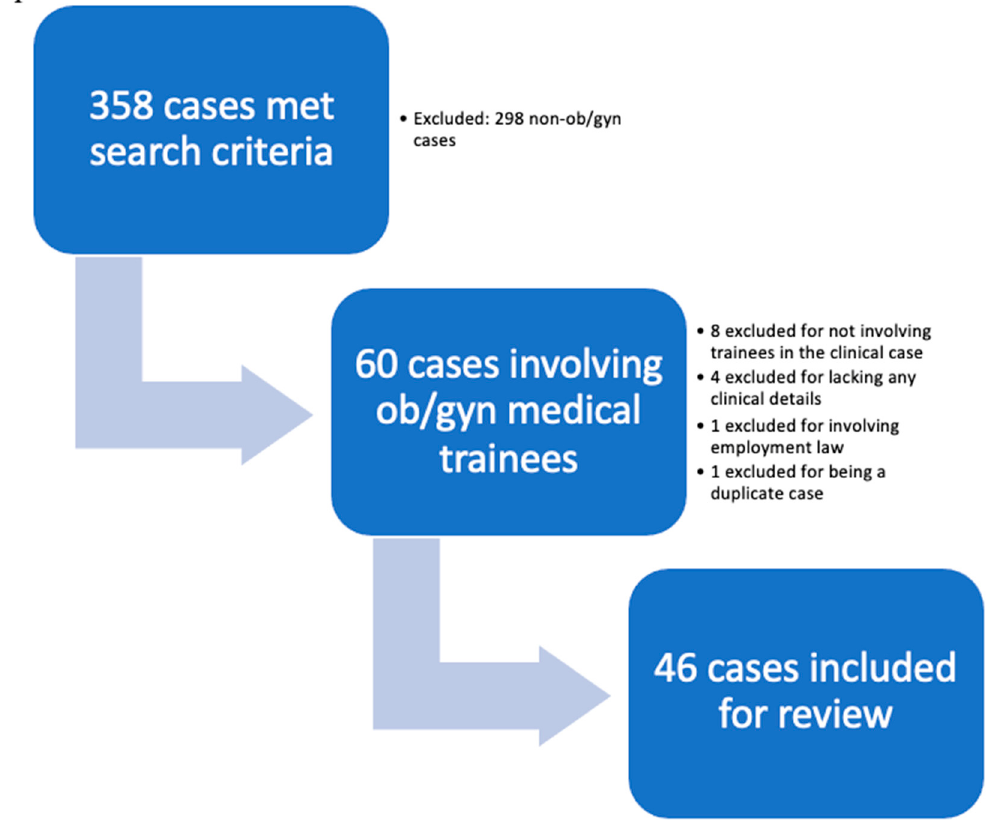
Figure 1. Selection process of cases.